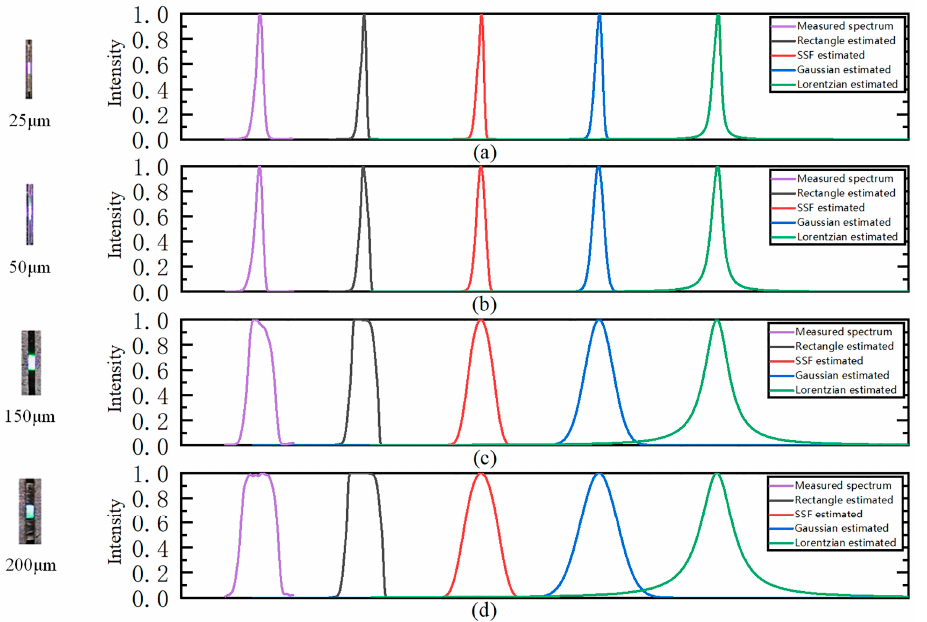
Figure 3. Wavelength resolutions at slits widths of ( a ) 25 μ m, ( b ) 50 μ m, ( c ) 150 μ m, and ( d ) 200 μ m. The circle represents the measured spectrum, and the cross, asterisk, triangle, and square represent the estimation results of rectangle function, convolution of SSF with rectangle function, Gaussian function, and Lorentzian function, respectively.